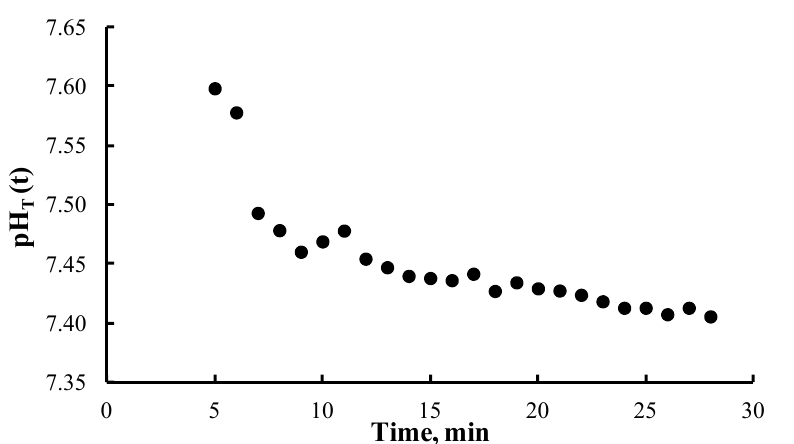
Figure 2. Time dependence of the measured pH T in the sediment core (Station CR14).